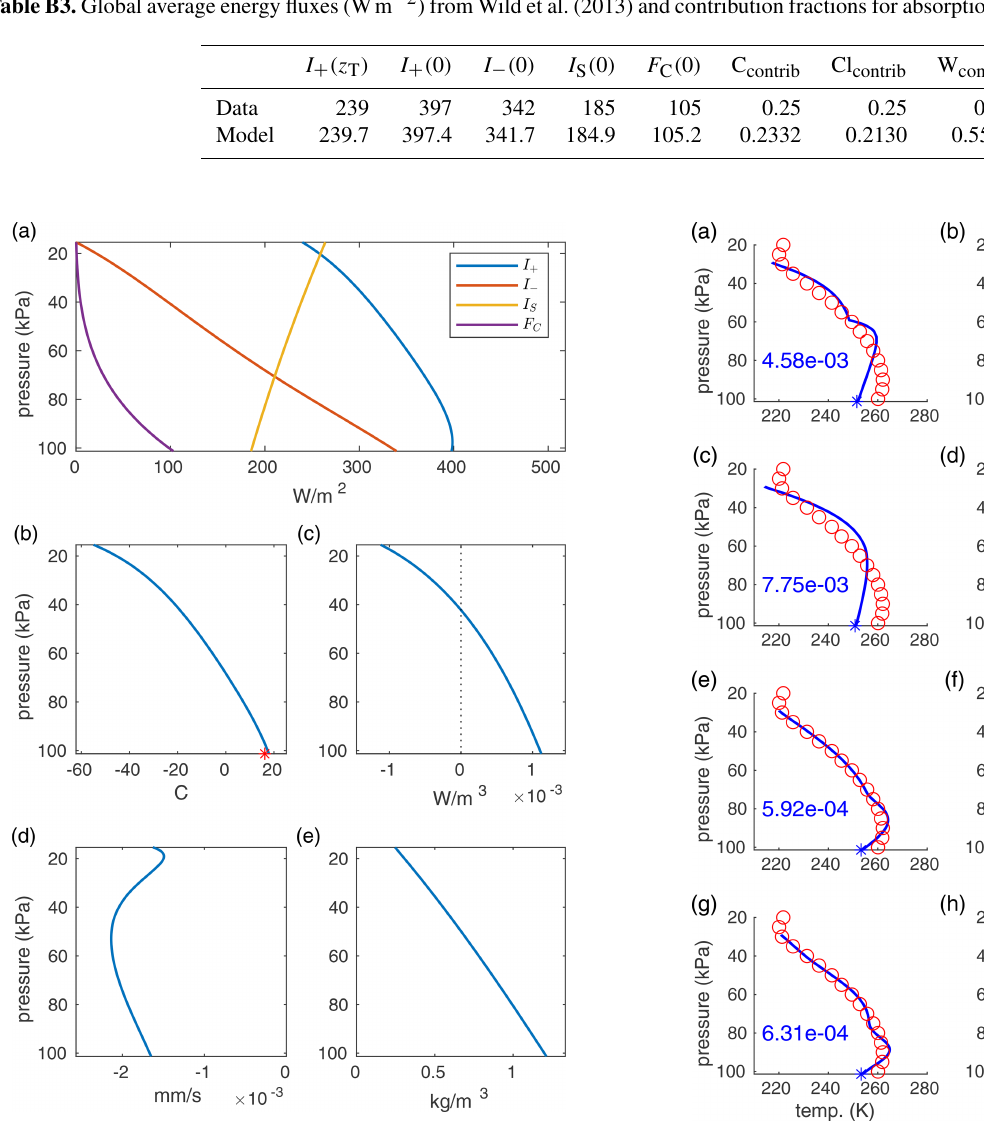
Table B3. Global average energy fluxes (Wm − 2 ) from Wild et al. (2013) and contribution fractions for absorption from Schmidt et al. (2010).